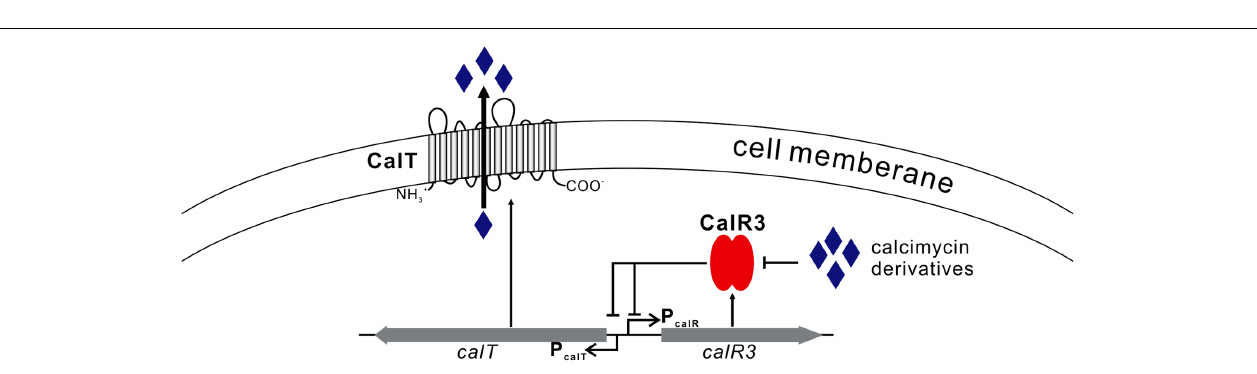
FIGURE 6 | Effects of calcimycin and cezomycin on CalR3 binding to T-R3L region. (Left) EMSA of His 6 -tagged CalR3 with concentrated fermentation broth of WT; (middle) EMSA of His 6 -tagged CalR3 with calcimycin; (right) EMSAs of His 6 -tagged CalR3 with cezomycin. Lanes –, control reaction without protein; lanes +, EMSA reaction in the presence of CalR3 protein. The concentrated fermentation broth, calcimycin and cezomycin were dissolved in methanol, and methanol was used as a solvent control.